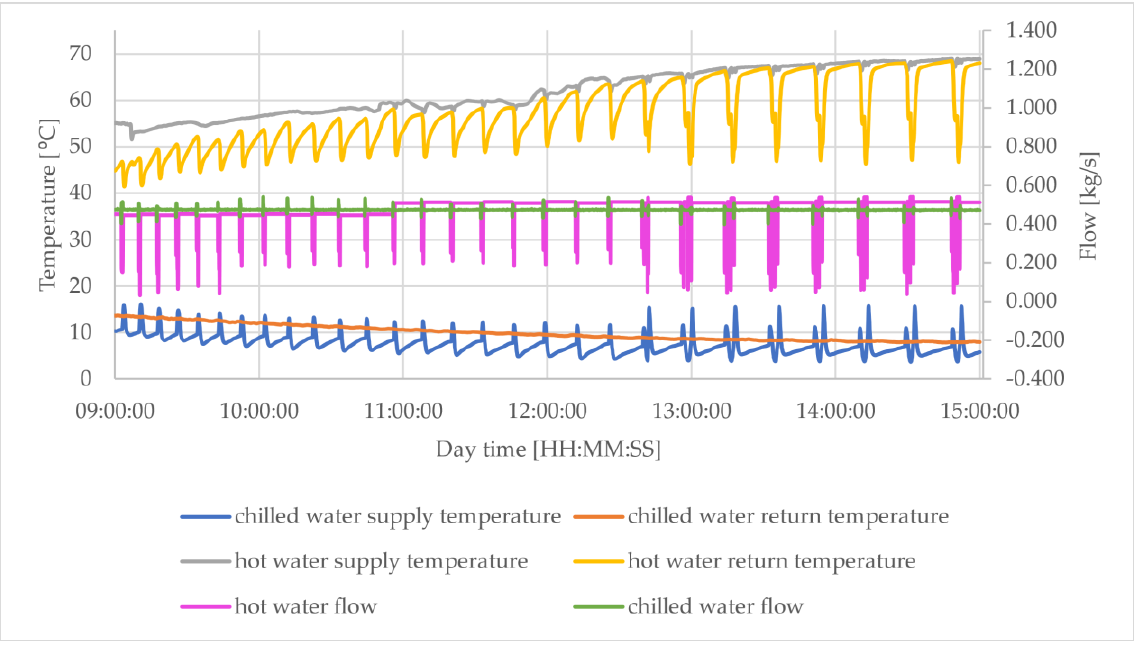
Figure 15. Measured values of temperatures and flow rates over time for 6th August.